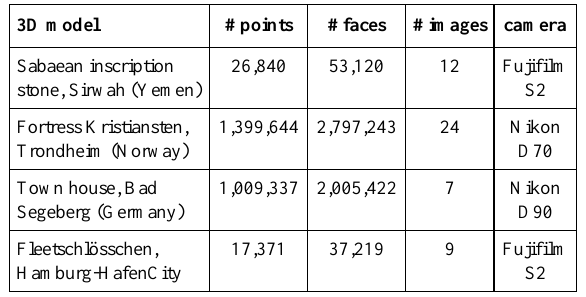
Table 1. Technical specifications of the used test data sets (3D models)